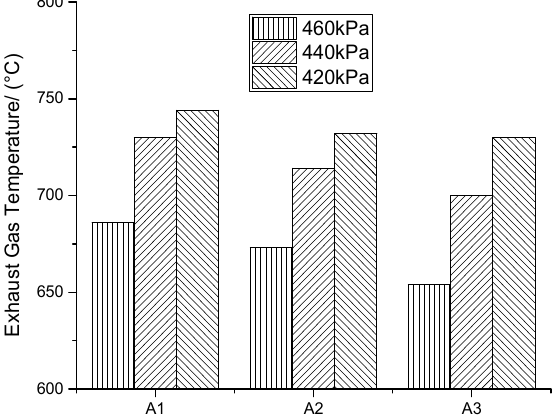
Figure 6. Exhaust temperature for different combustion chambers.